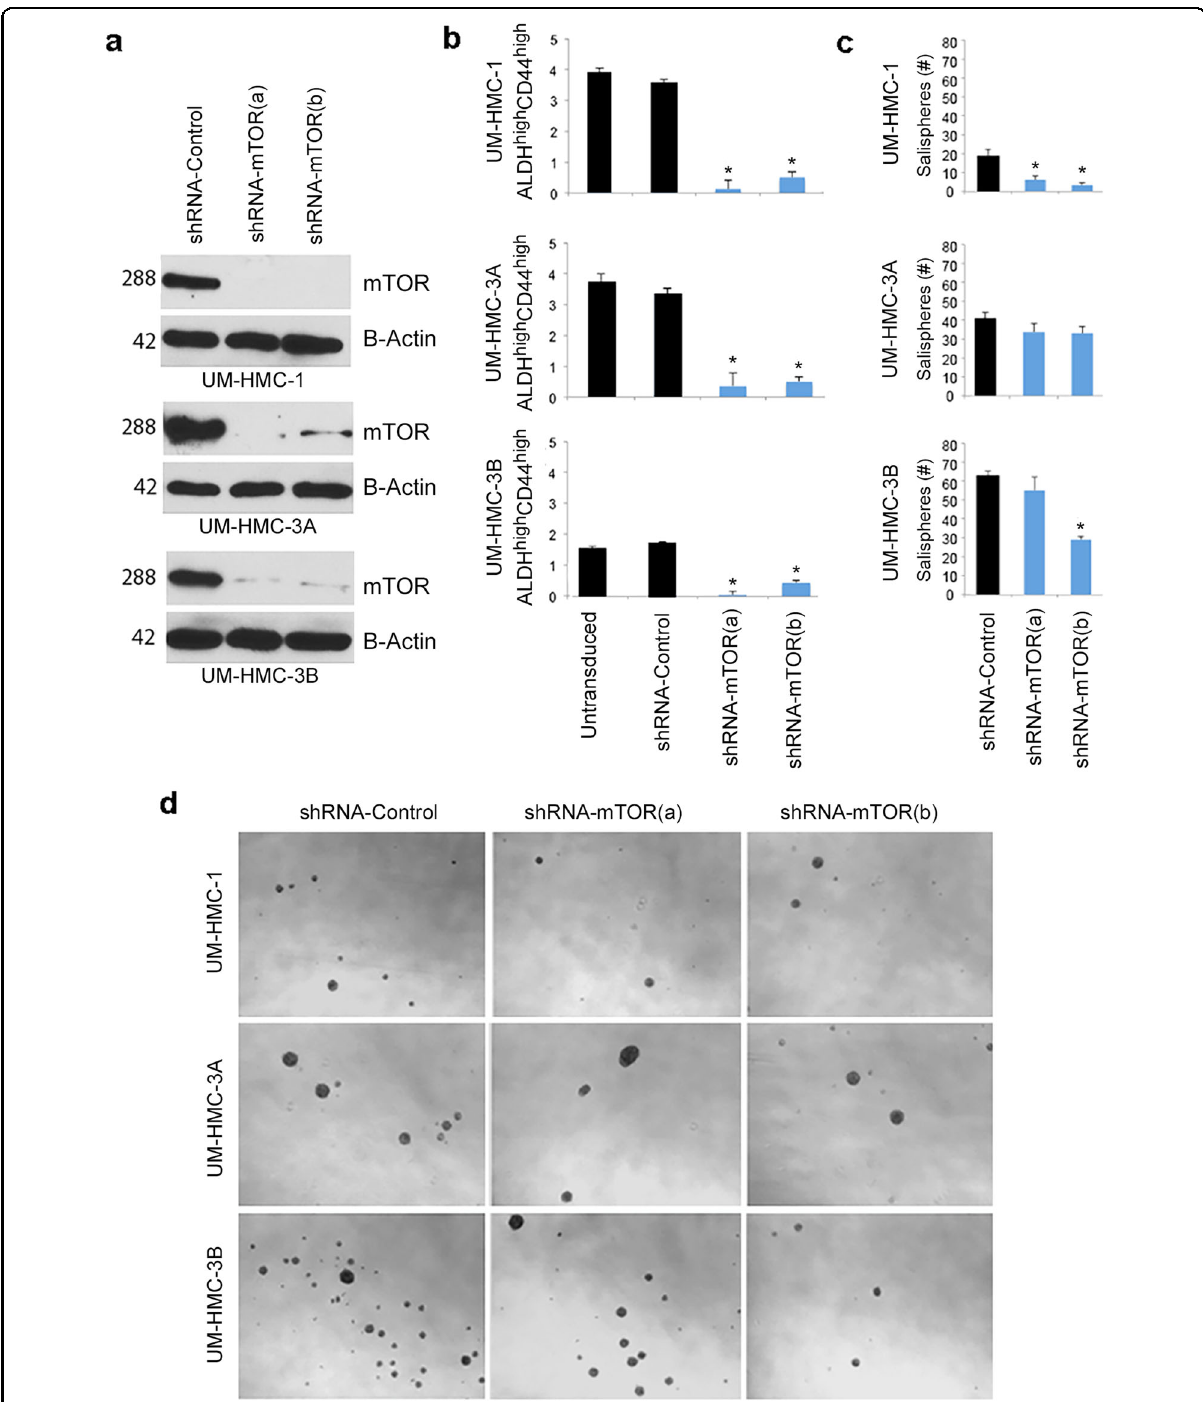
Fig. 4 mTOR silencing reduces the fraction of cancer stem-like cells. a Western blot analysis to mTOR expression in lysates obtained from mTOR- silenced (shRNA) cells (UM-HMC-1, UM-HMC-3A, and UM-HMC-3B) using two different shRNA sequences ( a , b ) or a scrambled sequence vector control (shRNA-control). b Graph depicting the fraction of ALDH high CD44 high cells (UM-HMC-1, UM-HMC-3A, and UM-HMC-3B) identi fi ed by fl ow cytometry in mTOR-silenced cells or vector controls. c Graphs depicting the average number of salispheres per well generated by mTOR-silenced cells or vector controls. d Representative images of the salispheres evaluated in c . Asterisk depicts p < 0.05, as determined by one-way ANOVA followed by post-hoc Tukey tests for multiple comparisons between shRNA-Control cells and cells transduced with shRNA-mTOR. Error bars indicate standard deviation (SD). Graphs for impacts of mTOR status on the fraction of ALDH high CD44 high or number of salispheres depict data from four wells per experimental condition. Experiments were performed three independent times to verify reproducibility of the